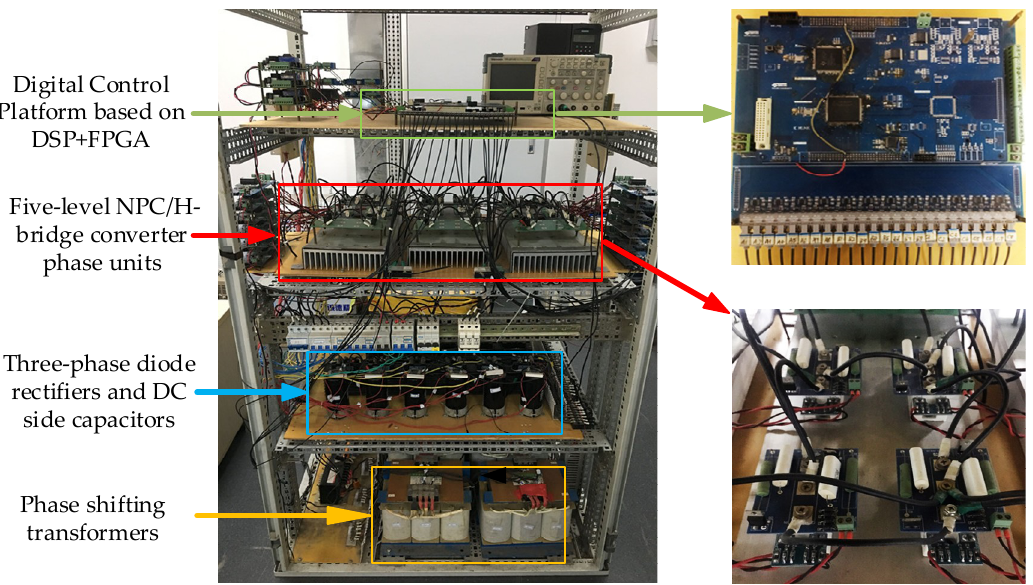
Figure 10. Three-phase neutral-point-clamped (NPC)/H-Bridge five-level converter experimental prototype.